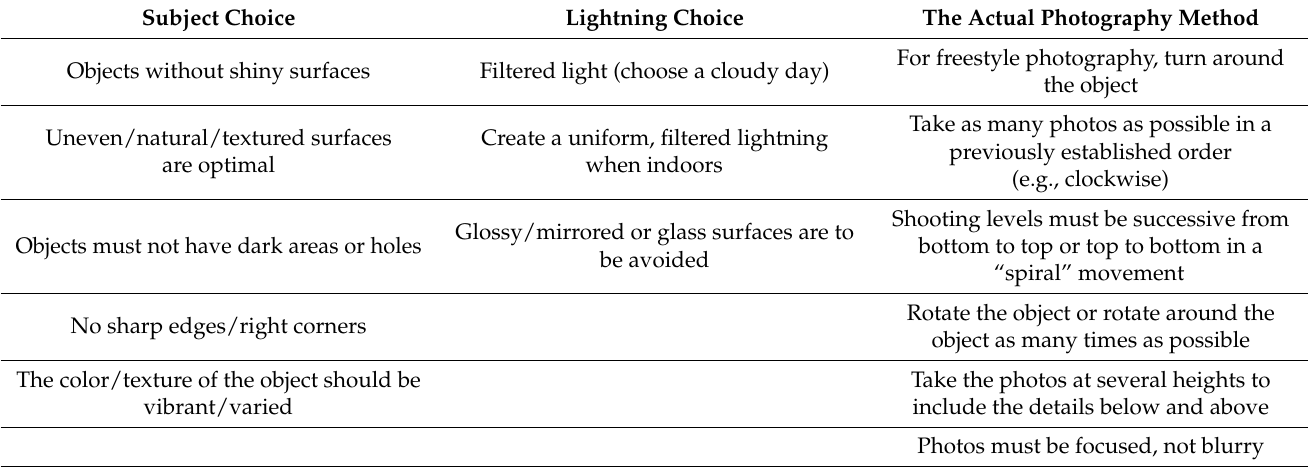
Table 1. Guidelines for the photogrammetry scanning technique